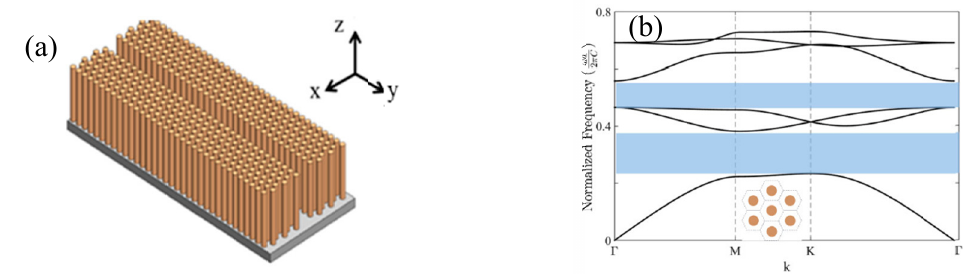
Figure 1. ( a ) A 3D Schematic representation of a PhC waveguide formed by removing a row of pillars in a periodic arrays of Si pillars on SiO 2 substrate. ( b ) Transverse electric band structure of a 2D hexagonal PhC made of Si pillars with the radius of r = 0.22a. The shadowed region represents the band gap of this structure. (Inset: schematic view of a 2D hexagonal lattice of Si